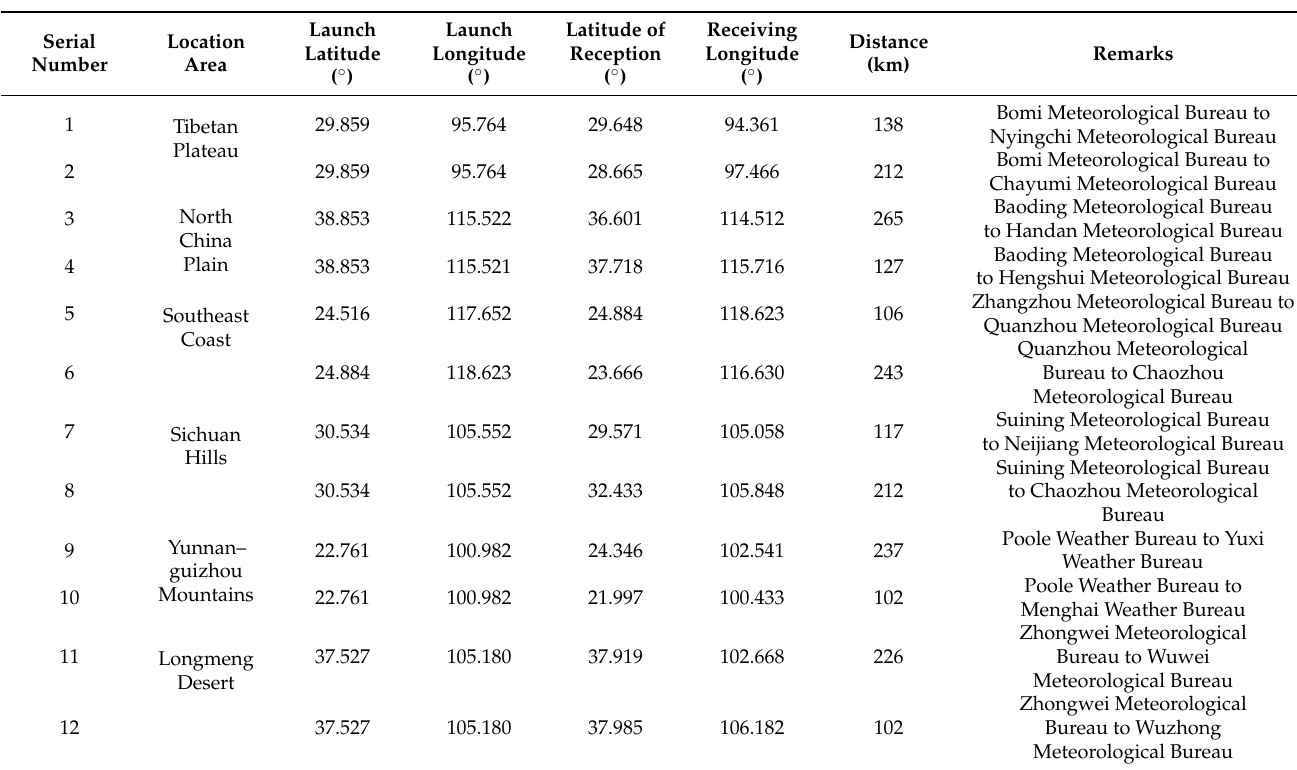
Table 1. Location parameters of 12 links in 6